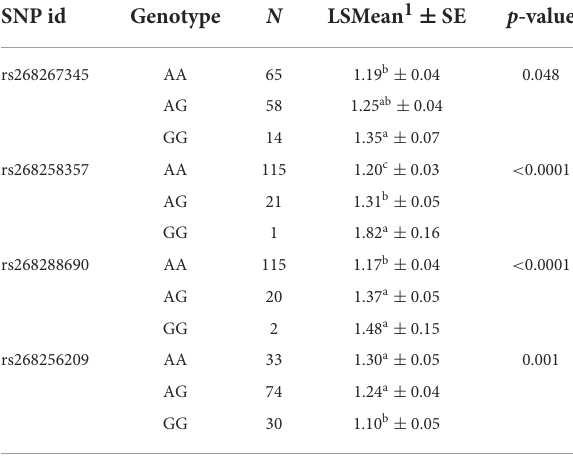
TABLE 3 Genotypic frequency and least-square mean ± standard error of litter size at birth for identified SNPs in the Markhoz